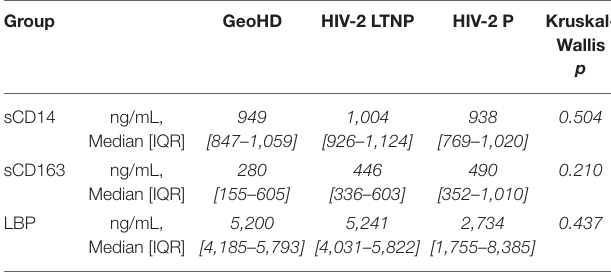
TABLE 4 | Comparison of sCD14, sCD163 and LBP plasma levels in HIV-2 infected participants of West-African origin and GeoHD. Group